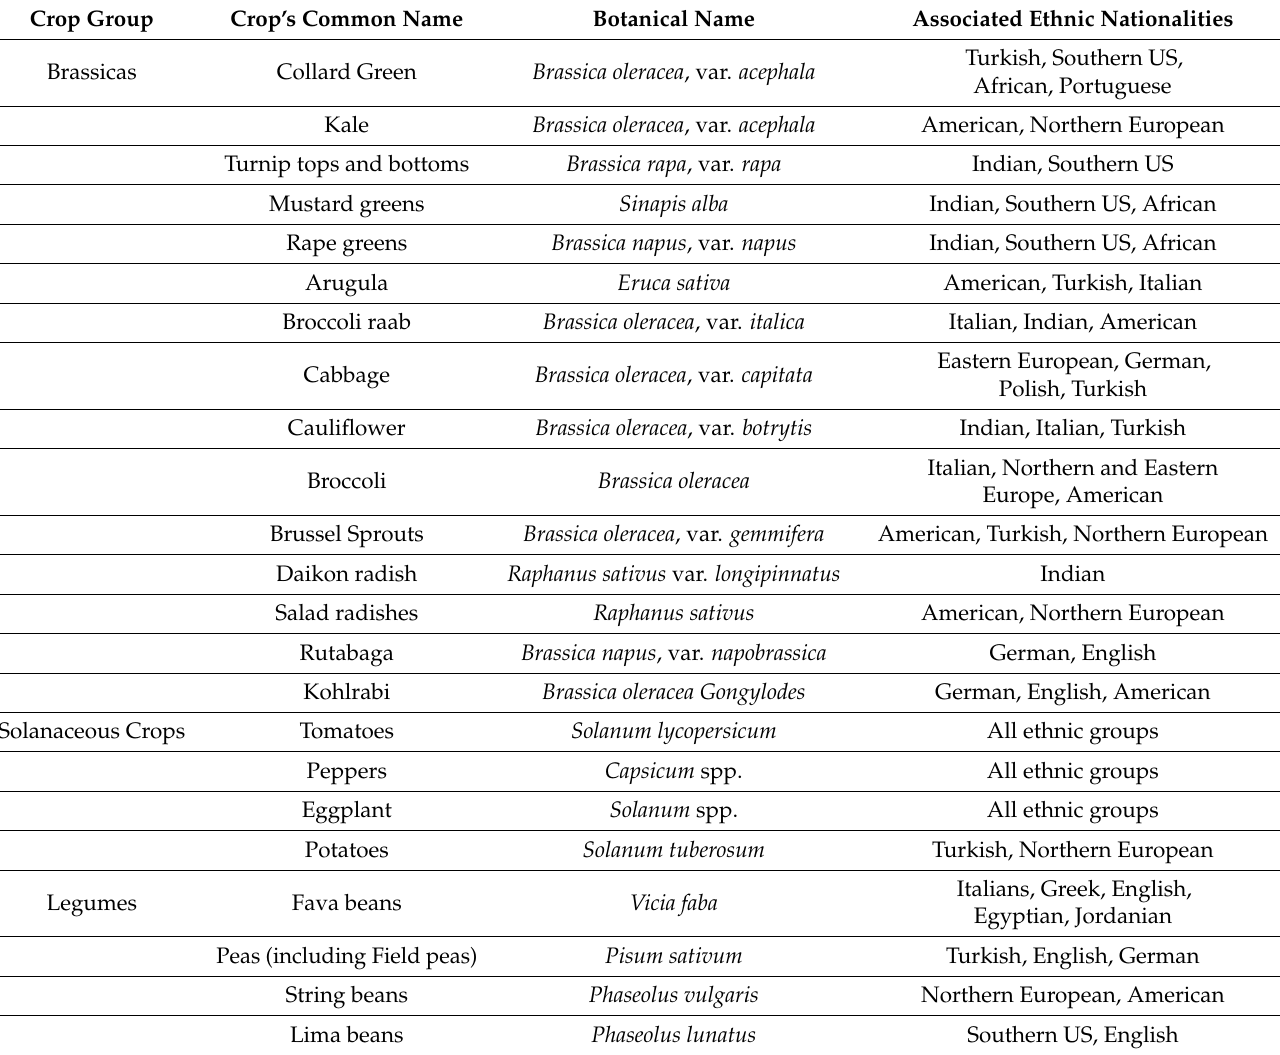
Table 1. Crop Classification and Associated Ethnic Nationalities at Specca Farms